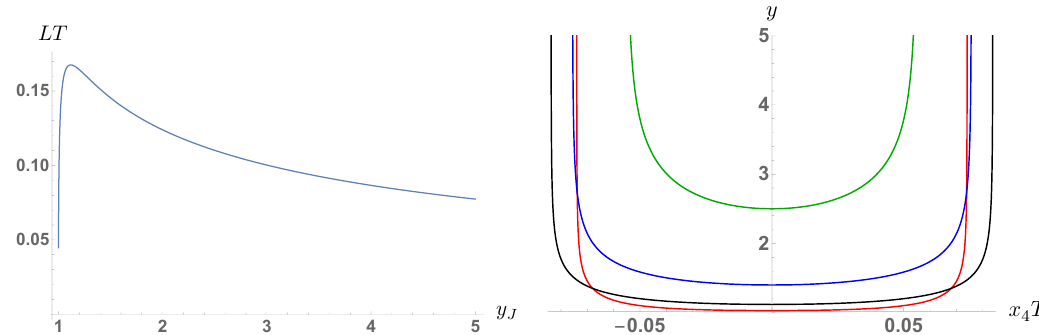
Figure 6 . Left: separation in x 4 times the temperature as a function of y J = u J /u T for the U-shaped configuration in the deconfined background. The maximum value of L T in the plot is L T ≈ 0 . 1675 and occurs for y J ≈ 1 . 119 . Right: profiles for different values of y J : y J = 1 . 03 (red), y J = 1 . 119 (black), y J = 1 . 4 (blue), y J = 2 . 5 (green). We have assumed, without loss of generality, that the tip of the brane is located at x 4 = 0